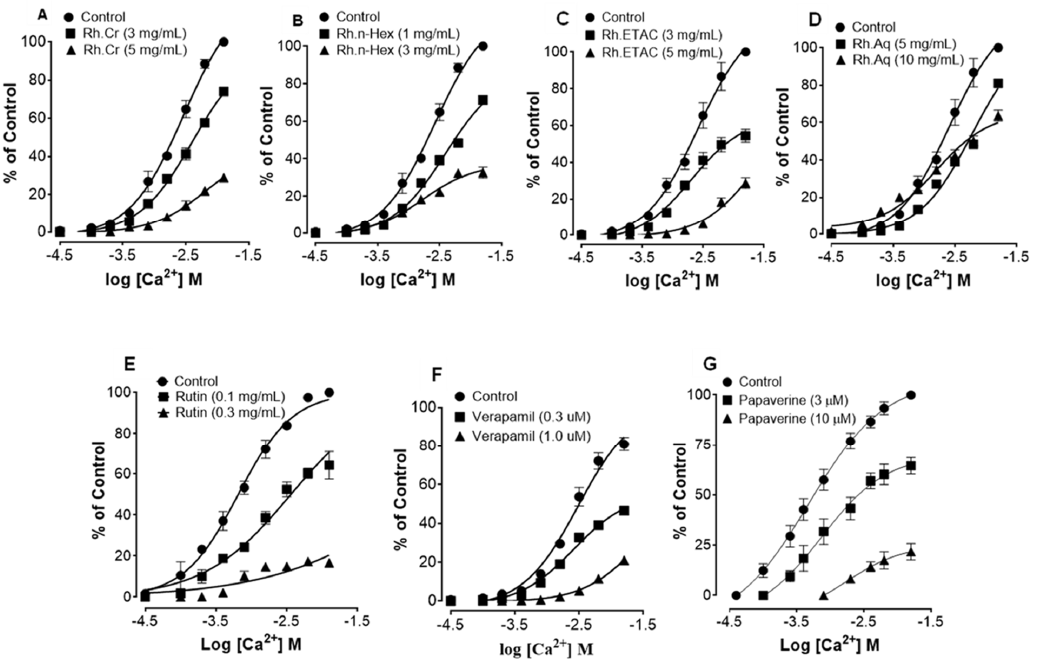
Figure 3. Concentration-response curves of Ca 2+ in the absence and presence of the increasing concentrations of ( A ) Rumex hastatas extract (Rh.Cr) and fractions: ( B ) n-hexane (Rh.n-Hex), ( C ) ethyl acetate (Rh.ETAC), ( D ) aqueous (Rh.Aq), ( E ) rutin ( F ) verapamil and ( G ) papaverine in isolated rabbit jejunum preparations. Values are expressed as mean ± SEM ( n = 4-5).